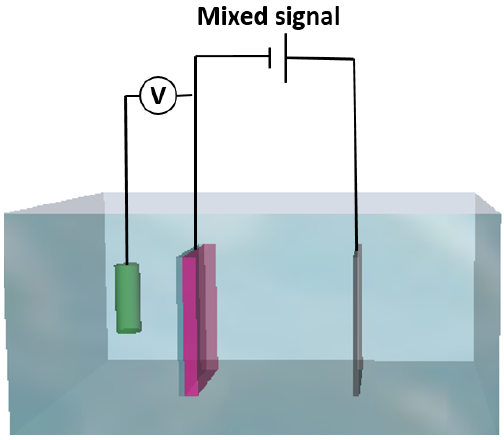
Figure 1. Electrochemical deposition system.